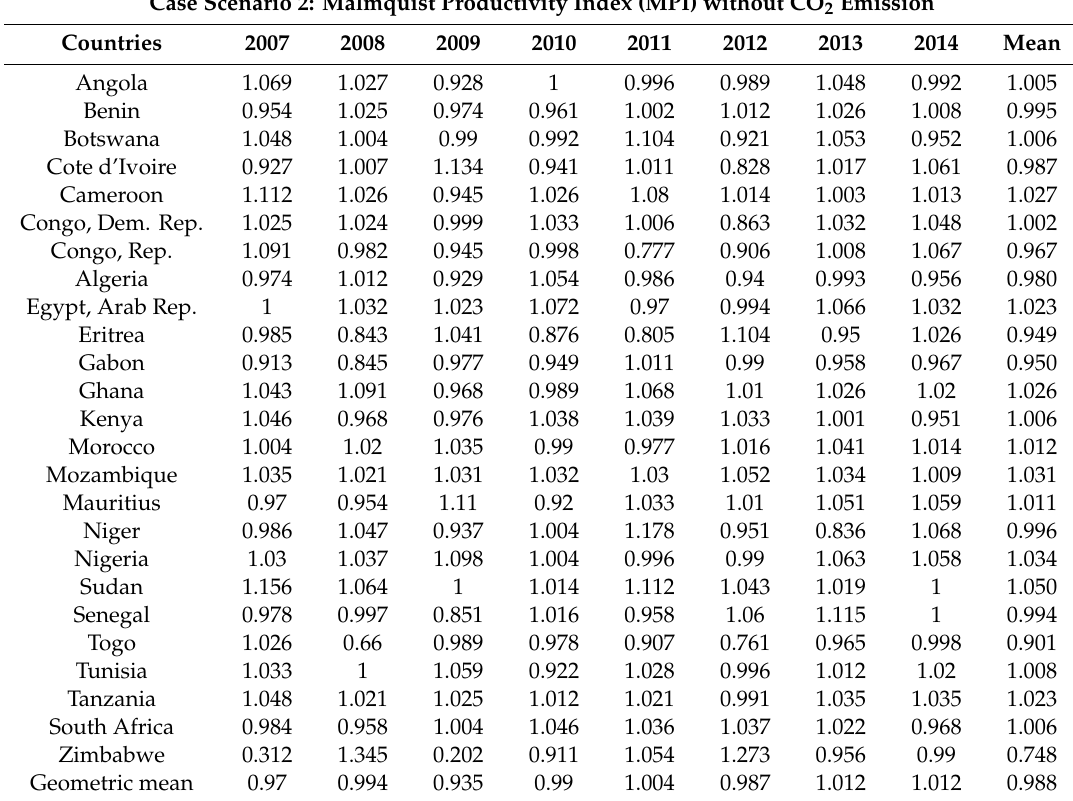
Table 2. The energy productivity estimates without CO 2 emissions in Africa during